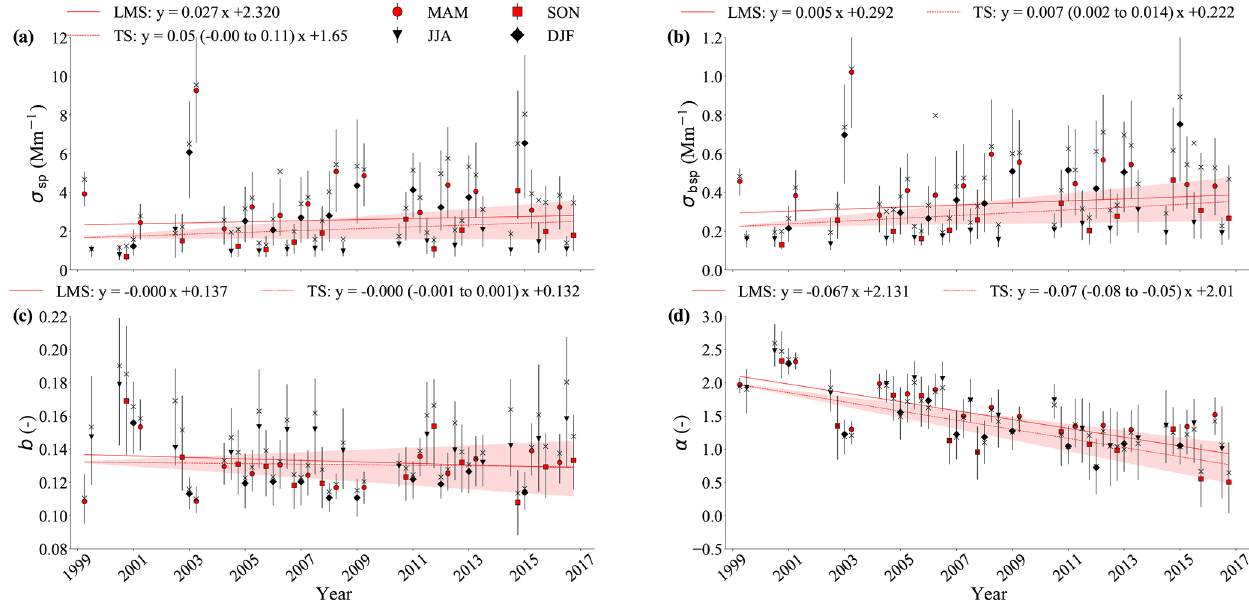
Figure 1. Long-term trends of the seasonal medians for (a) the particle light scattering coefficient ( λ = 550nm), (b) the particle light backscattering coefficient ( λ = 550nm), (c) the hemispheric backscattering fraction ( λ = 550nm), and (d) the scattering Ångström exponent ( λ 1 = 450nm, λ 2 = 550nm). The seasonal medians are denoted by their respective symbols. The error bars denote the length of the 25th and 75th percentile values. The seasonal mean is given by the cross. The solid and dashed red lines represent the least mean square (LMS) and Theil–Sen slope (TS) of the seasonal medians, respectively. The red shaded area denotes the associated 90% confidence interval of the TS slope. Note that TS is not used to test the statistical significance.